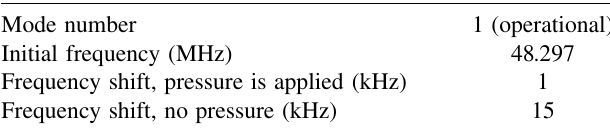
TABLE V. ANSYS simulation results for frequency detuning due to the effect of the